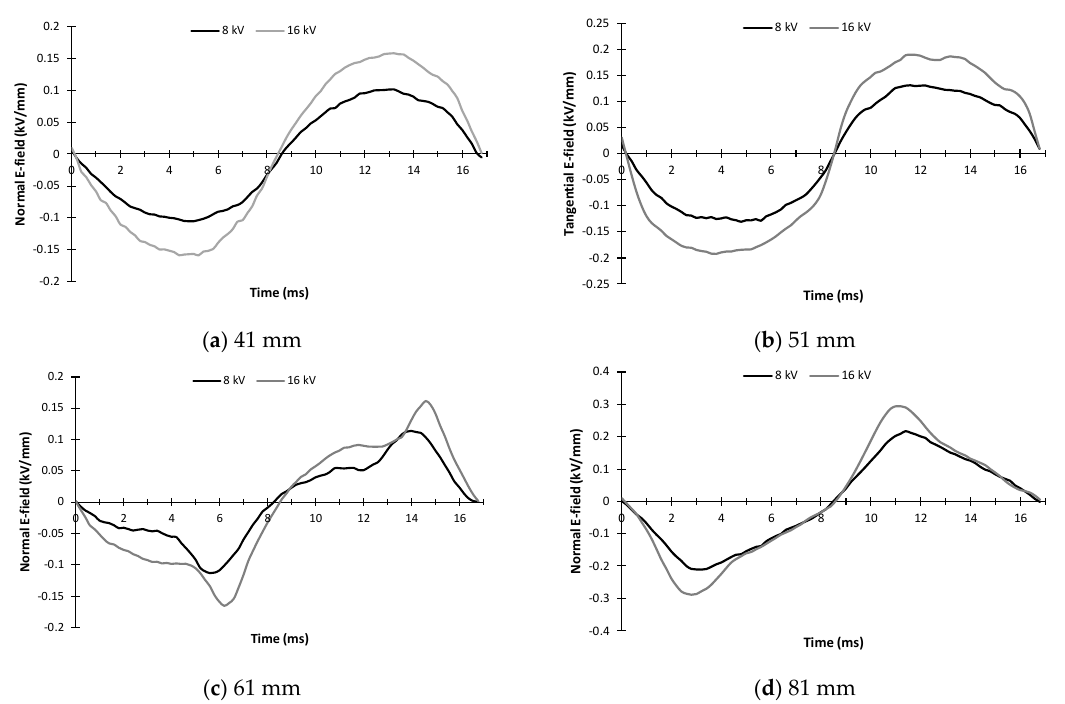
Figure 16. Comparison of the normal E-field snapshot for an applied voltage of 8 kV rms obtained along